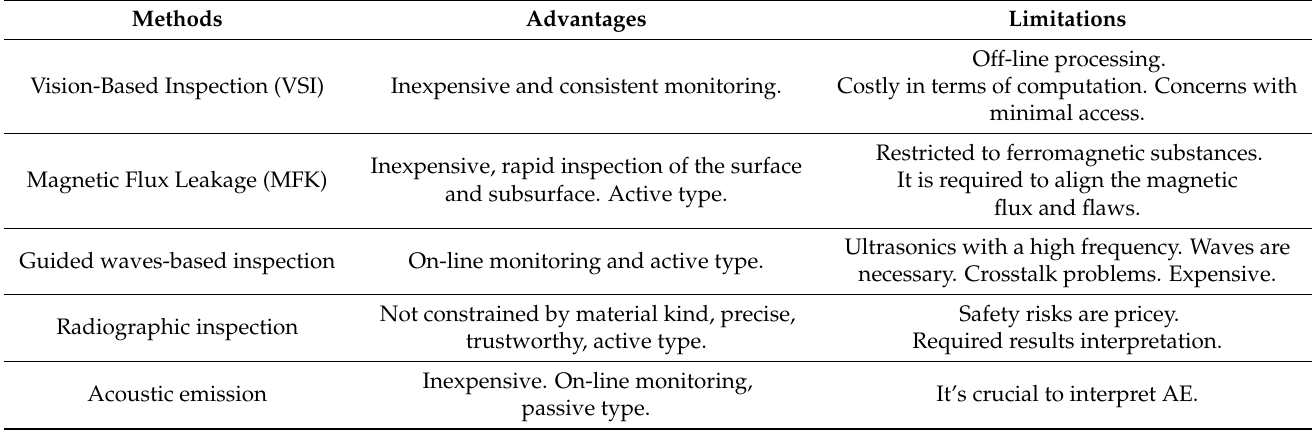
Table 4. Non-destructive testing techniques comparison for corrosion